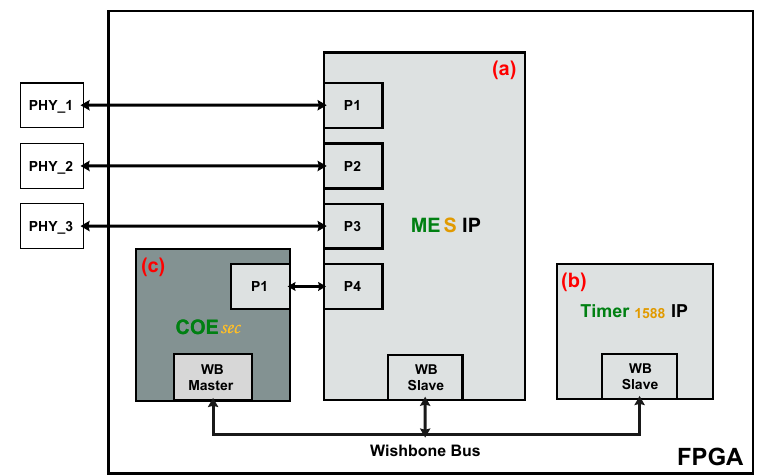
Figure 5. Architecture to measure COEsec timing. Includes ( a ) 4-port Managed Ethernet Switch (MES) IP. ( b ) IEEE1588 Timer and Timestamping IP. ( c ) COEsec IP instance.